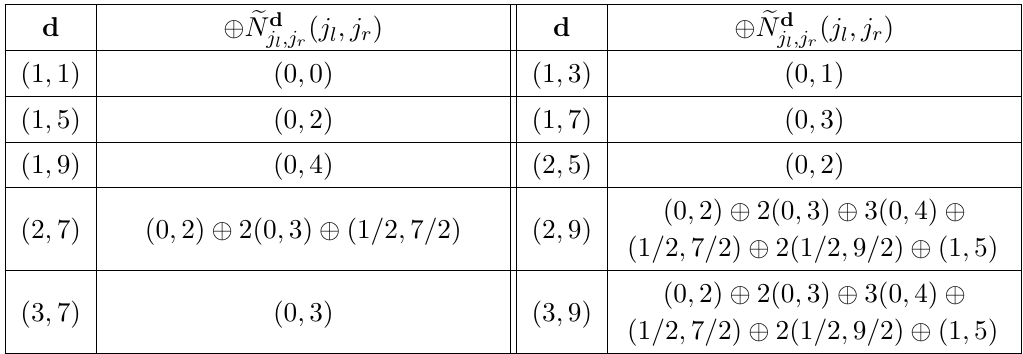
Table 1 . BPS Spectrum of SU(2) Wilson loop expectation value in the representation 2 for the curve class d 1 m 0 + d 2 φ with d 1 = 1 , 2 , 3 , and d 2 ≤ 9 . The d 1 = 0 part can be read from